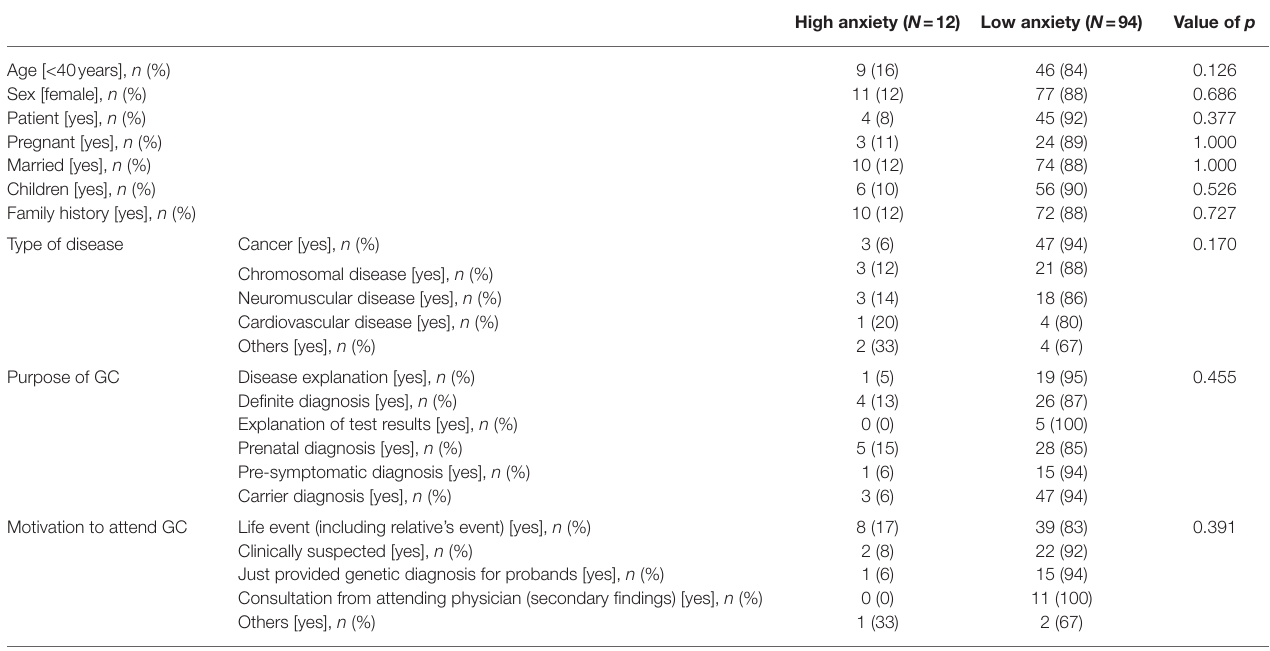
TABLE 5 | Trait anxiety by the characteristics of GC